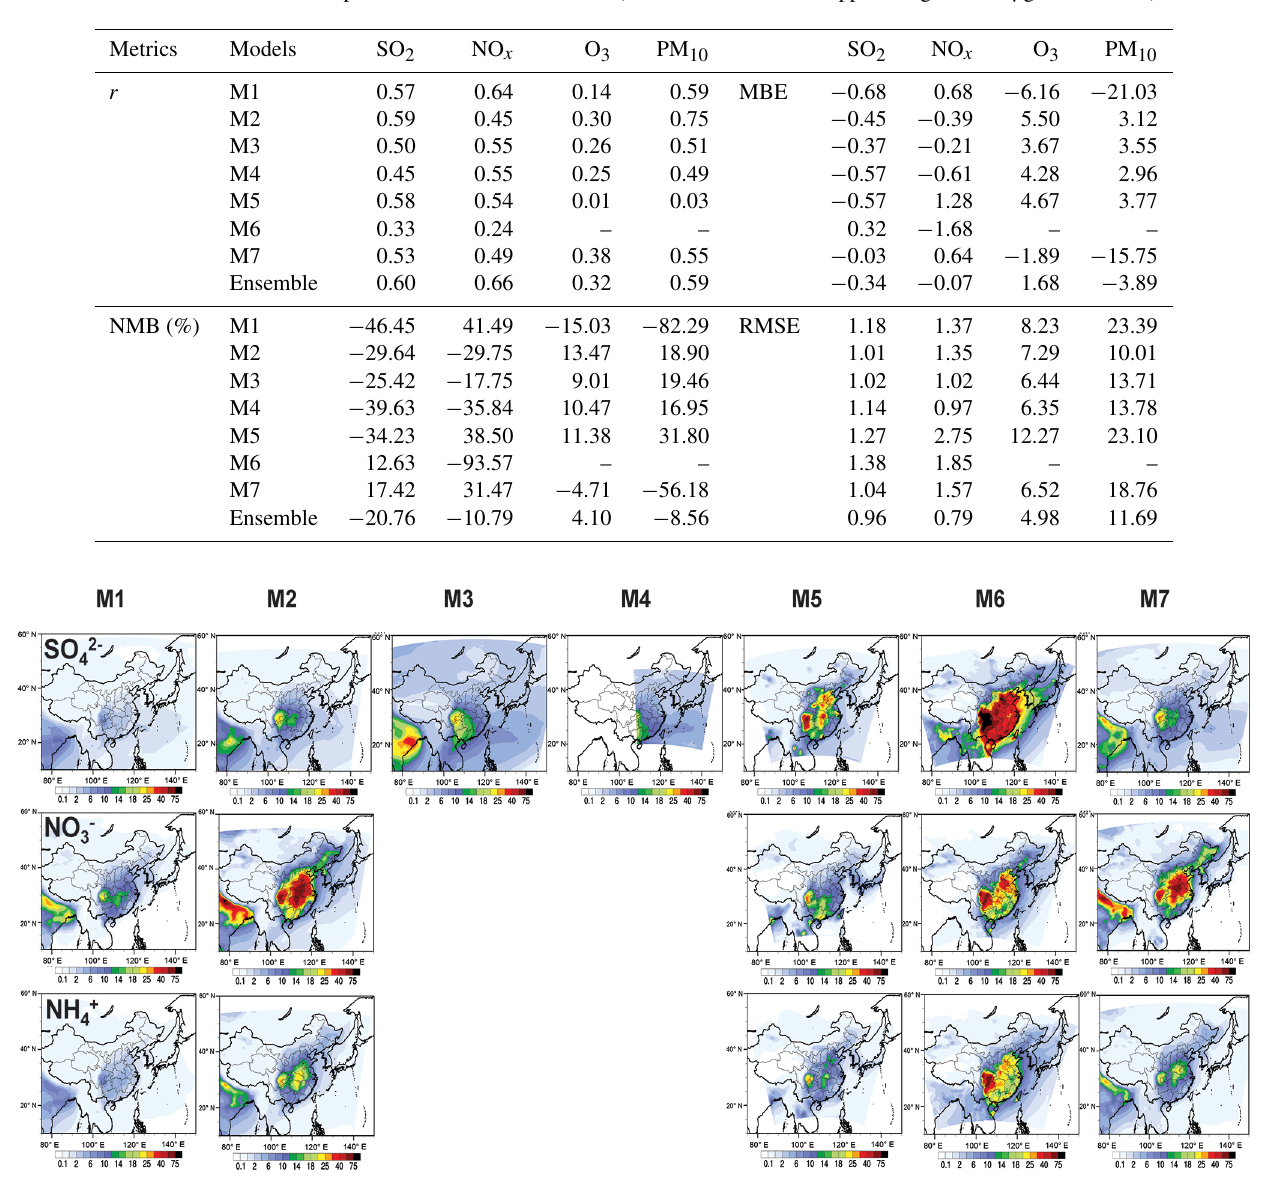
Figure 7. Simulated monthly concentrations of major PM 2 . 5 components (µgm − 3 ) for January 2010 from all participating